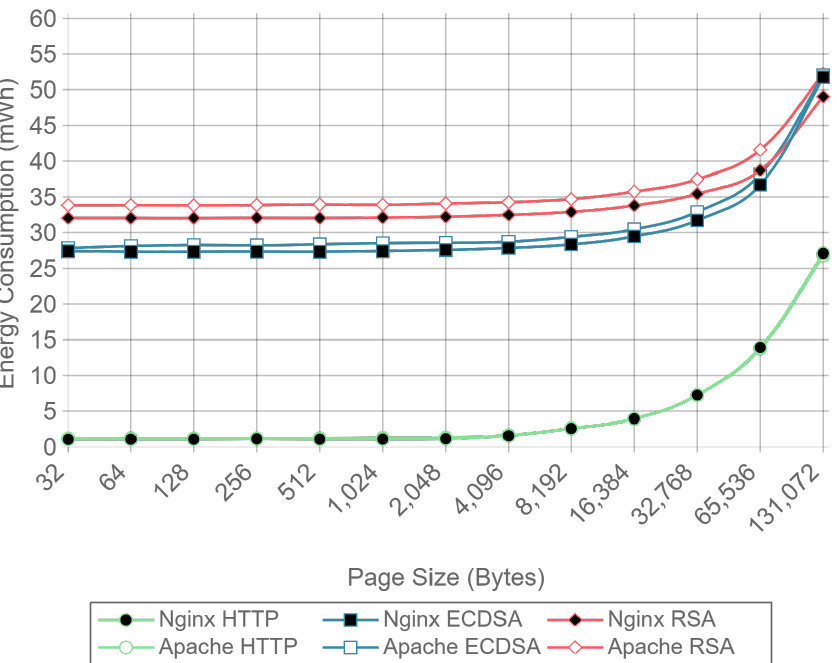
Figure 18. Client-side page size versus energy consumption for Apache2 and Nginx with 128 concurrent